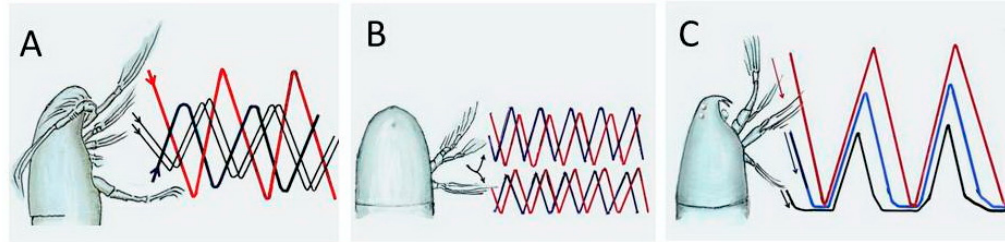
Figure 1. Schematic representation of the action of cephalic appendages in calanoid copepods in terms of their angular movements during cruise swimming. Each line starts from the nearest drawn cephalic appendages. ( A ): Calanus helgolandicus . The red and two thin black lines directed downward correspond to the angular movement of second antennas, mandibles, and maxillas; the blue line directed up corresponds to the movement of maxillipeds (from [12]). ( B ): Eurytemora affinis. The upper red and blue lines show the movement of exopodite and endopodite, respectively, of the second antenna; the lower red and blue lines correspond to the movement of the exopodite and endopodite, respectively, of the mandible. ( C ): Anomalocera patersoni. Red, blue, and black lines correspond to movement of second antennas, mandibles, and maxillas, respectively.